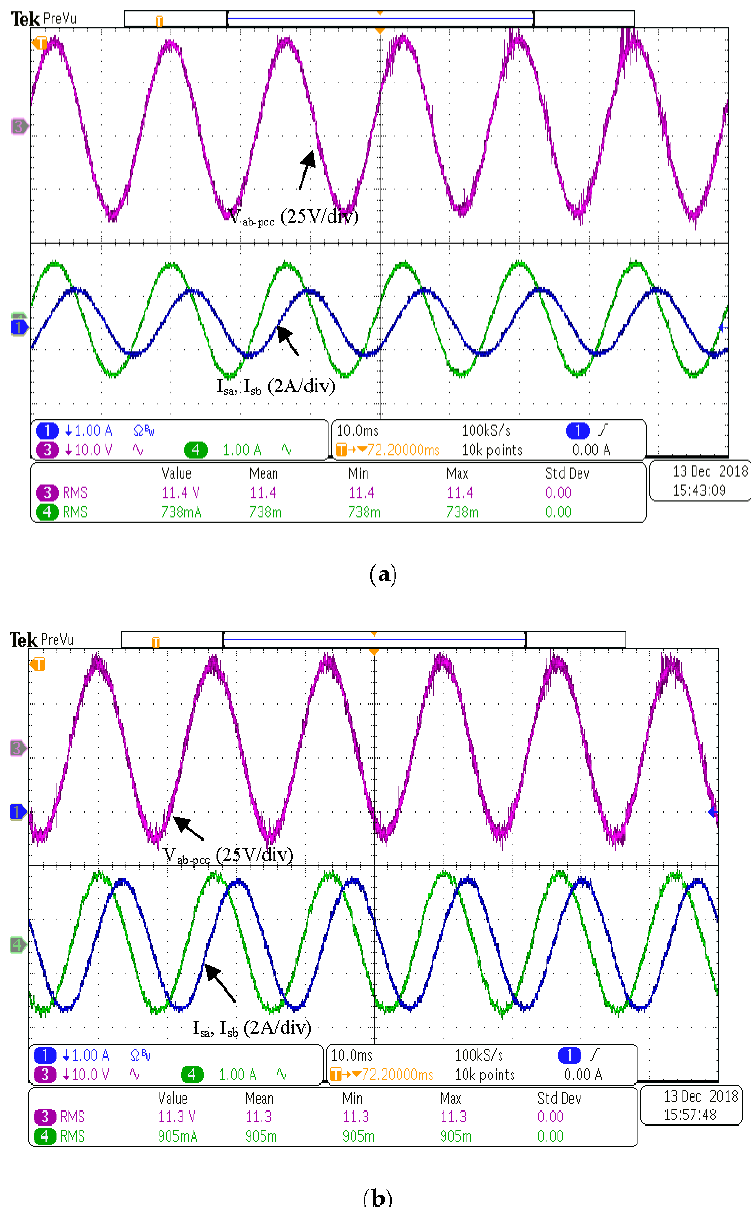
Figure 14. ( a ) vab-pcc, isa and isb without the filter. ( b ) vab-pcc, isa, isb and ifb with the filter. (10 ms/div).